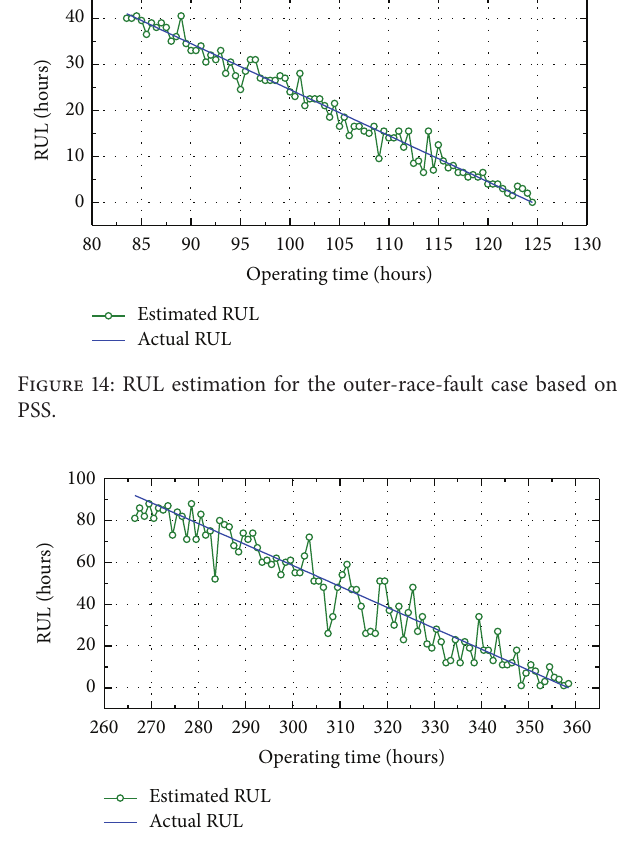
Figure 18: RUL estimation for the inner-race-fault case based on original signal similarity.